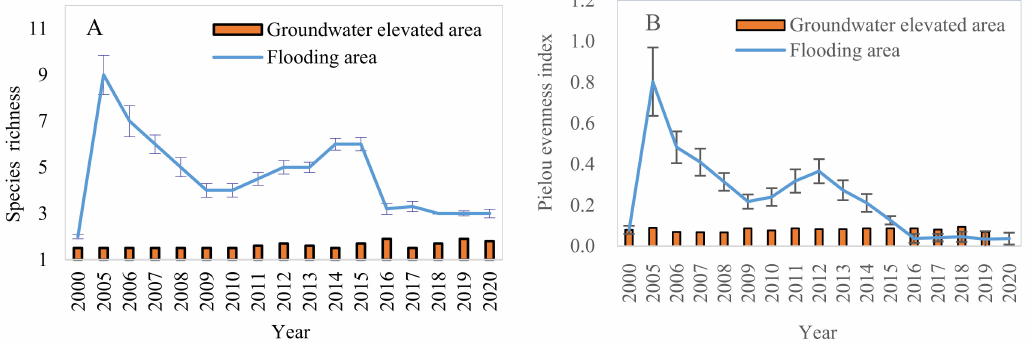
Figure 4. Species richness ( A ) and Pielou evenness index ( B ) of flooding area and groundwater elevated area of the terminal lake of Tarim